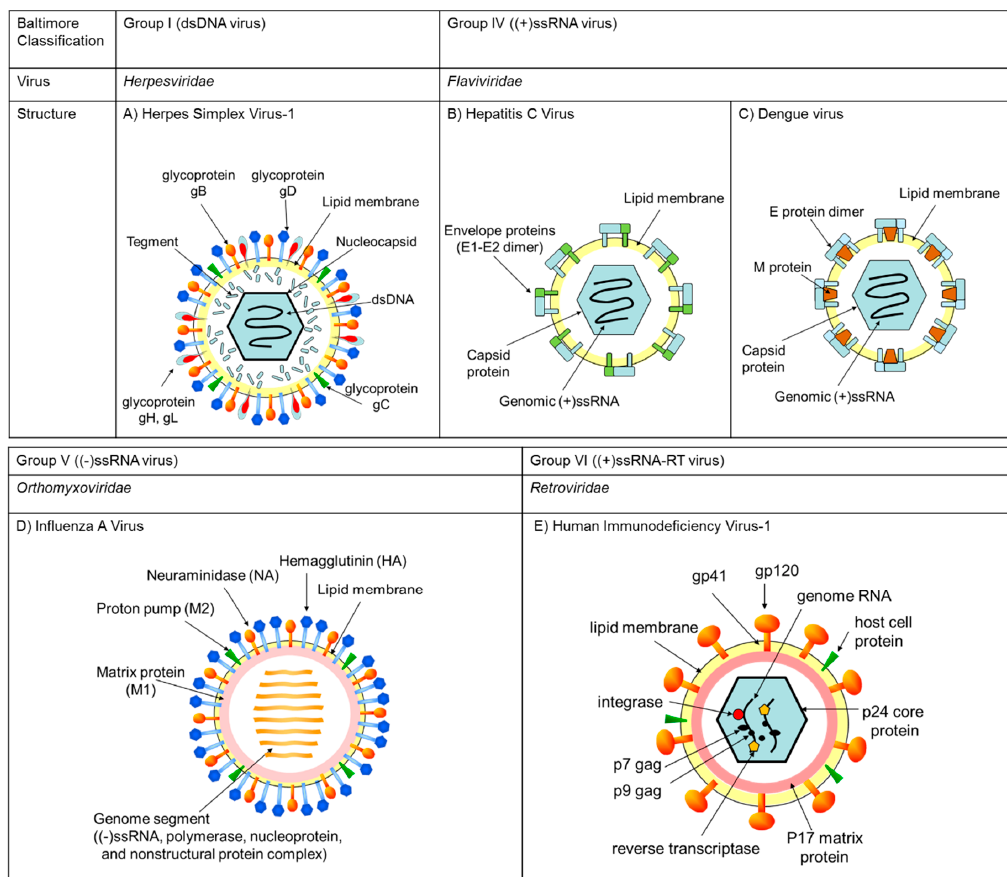
Figure 2. The DNA and RNA viruses described in this study were classified by Baltimore group. A representative of each virus family and their structures are summarized in the figures. ( A ) Herpes simplex virus-1 is a member of Herpesviridae , classified to Baltimore group I possessing dsDNA as the genome in a nucleocapsid core enveloped by lipid membrane. ( B ) Hepatitis C virus and ( C ) Dengue virus are member of Flaviviridae , classified to Baltimore group IV possessing a (+) single-stranded RNA genome in the viral particle. ( D ) Influenza A virus is a member of Orthomyxoviridae , classified to Baltimore group V possessing eight ( − )-strand viral RNA genomes in the viral particle. ( E ) Human immunodeficiency virus-1 is a member of Retroviridae , classified to Baltimore VI possessing two (+)- strand RNA genomes in a protein core in the viral